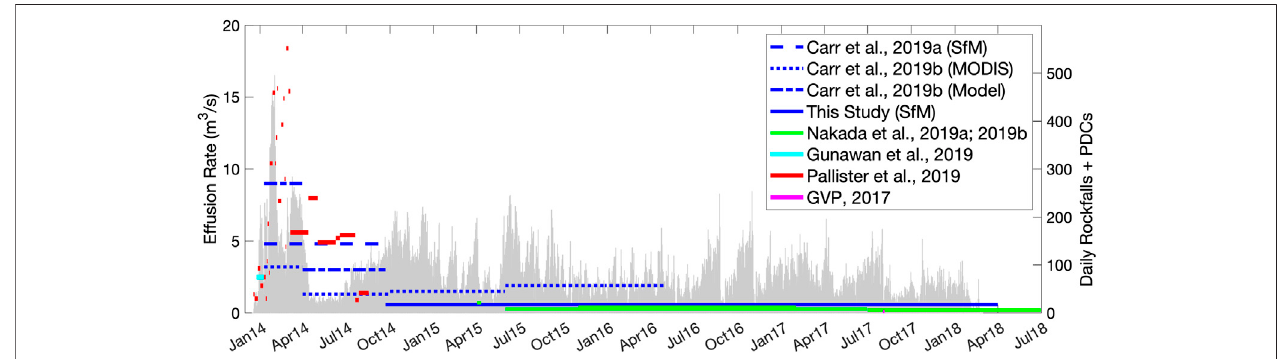
FIGURE2 | SinabungEruptionHistory.EffusionrateatSinabung(horizontallines)increasedrapidlyinearly2014beforeslowlydecreasingoverthenextfewyears.The frequency of PDCs and rockfalls (gray bars, modi fi ed from Kriswati and Solikhin, 2020, data only through February 2018) was highest in the early months of 2014 when effusionrateand fl owadvanceratewerehighestandlowestinthemiddleof2014whenthelava fl owin fl ated.IncreasesinPDCsaroundOctober2014andJune2015were causedbytheinstabilitiesthatdevelopedwhenlavaovertoppedcon fi ningridgelines,generatingpassivecollapsesoftheupper fl ow.Spikesinthefrequencyofcollapses during2016and2017wereactivecollapsesassociatedwithVulcanianexplosionscausedbygaspressurizationwithinthelavadome.Thesepatternsdemonstratehowboth passive collapses and gas overpressure-driven active collapses can cause an increase in collapse activity without a corresponding increase in eruption